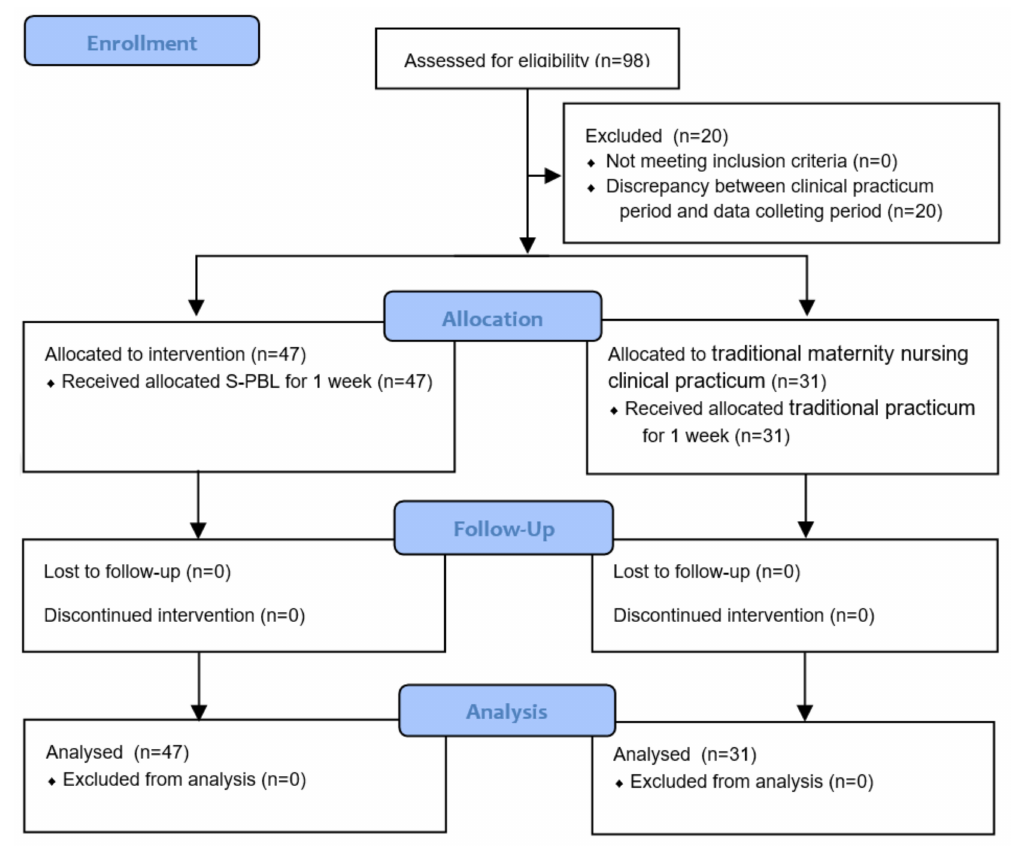
Figure 3. Research